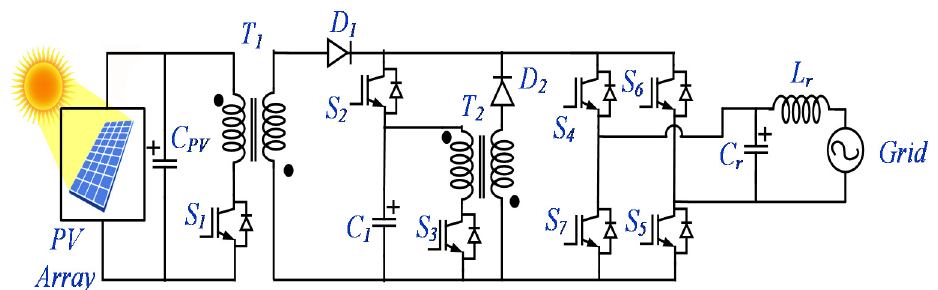
Figure 36. Fly-back converter with High Frequency AC linked active decoupling circuit.